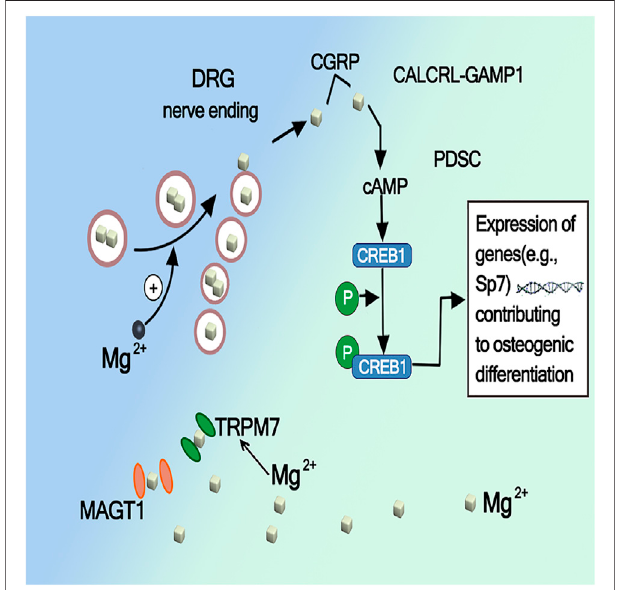
FIGURE 6 | Activation of CREB1 and SP7 by Mg mediated CGRP (Zhang et al., 2016) .